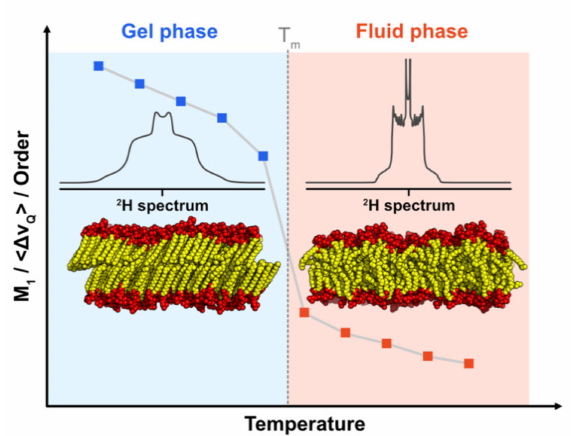
Figure 4. Influence of the temperature on lipid membrane dynamics. At low temperatures ( left part), the lipids are in the gel phase where all the chains are fully elongated, leading to rather low dynamics (i.e., highly ordered), which is transcribed by 2 H NMR in a characteristic wide spectrum. As a consequence, the values of M 1 or < ∆ ν Q > , derived from the spectral width, are also high. In contrast, at higher temperatures ( right part), the lipids are in the fluid phase and the chains are quite disordered. The corresponding 2 H NMR spectrum is narrower, leading to lower values for M 1 and < ∆ ν Q > . The temperature where the transition between the gel phase and the fluid phase occurs is noted as T m (for “melting”